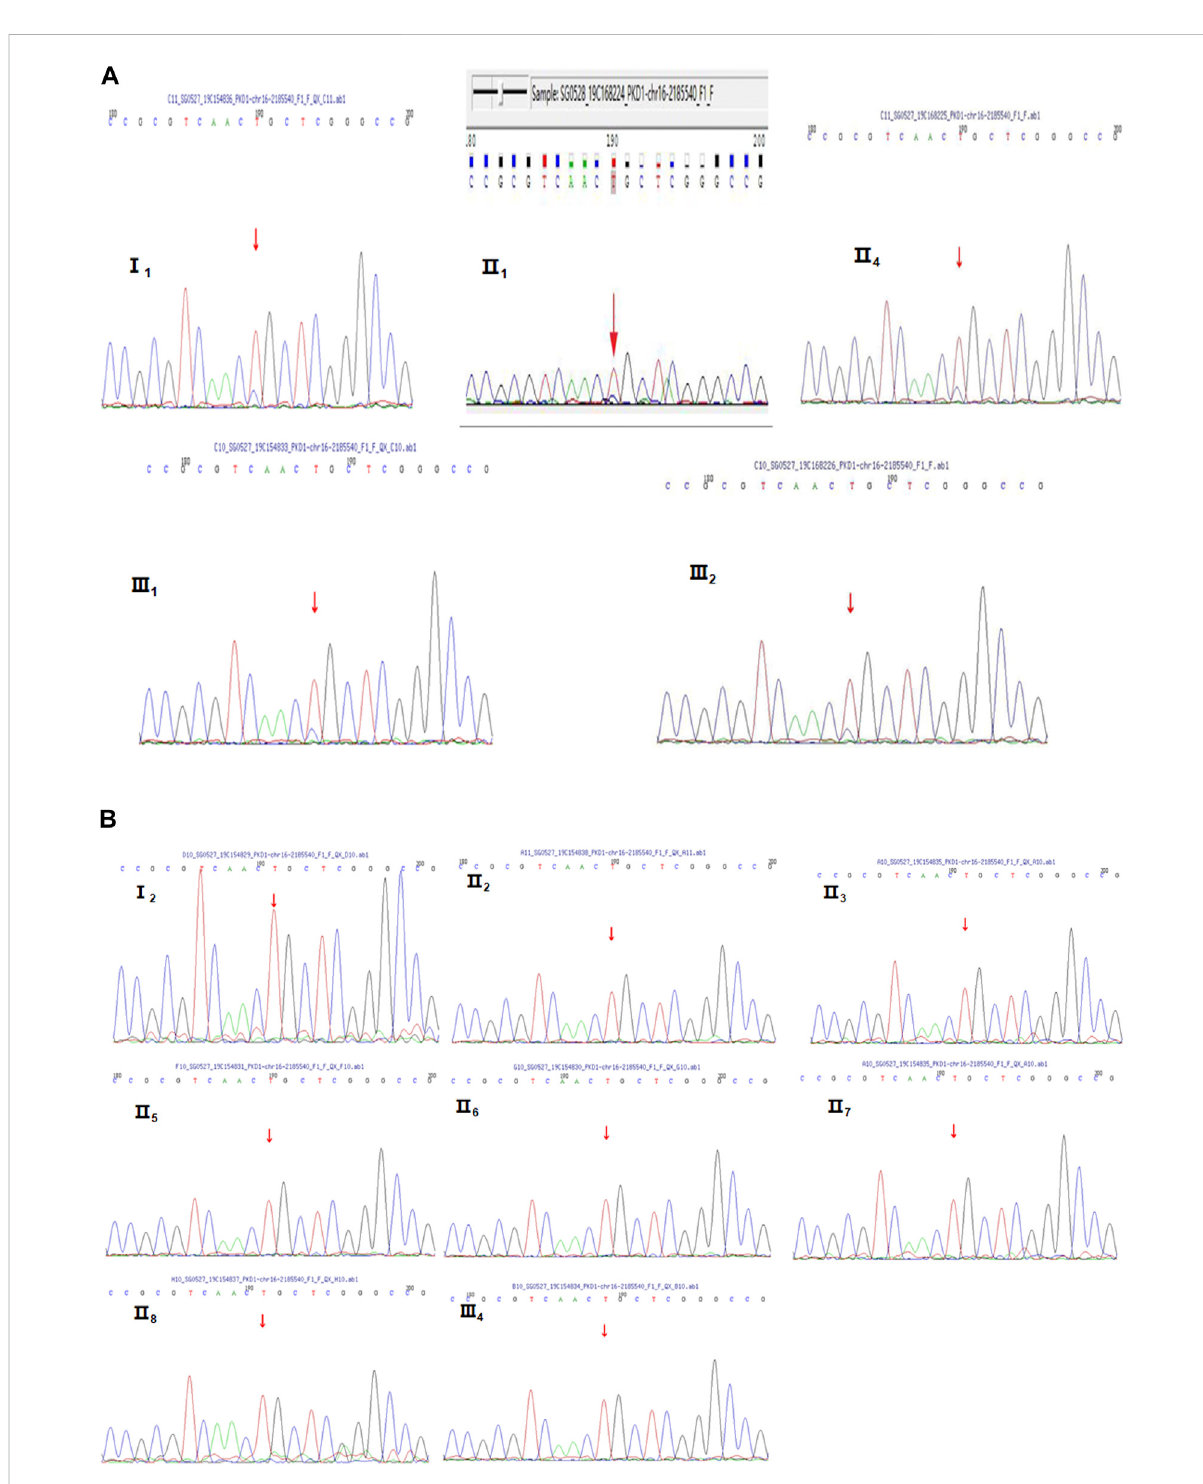
FIGURE 2 Sanger sequencing diagrams of the Case 1 pedigree. (A) , III 2 , II 4 , I 1 , II 1 , and III 1 show the heterozygous mutation at NM_001009944:c.151T > C. The red arrow indicates the mutation position. (B) , II 3 , I 2 , II 6 , II 5 , III 3 , III 4 , II 7 , II 8 , and II 2 indicate that there is no mutation in NM_001009944:c.151T > C. There is no mutation at the position indicated by the red